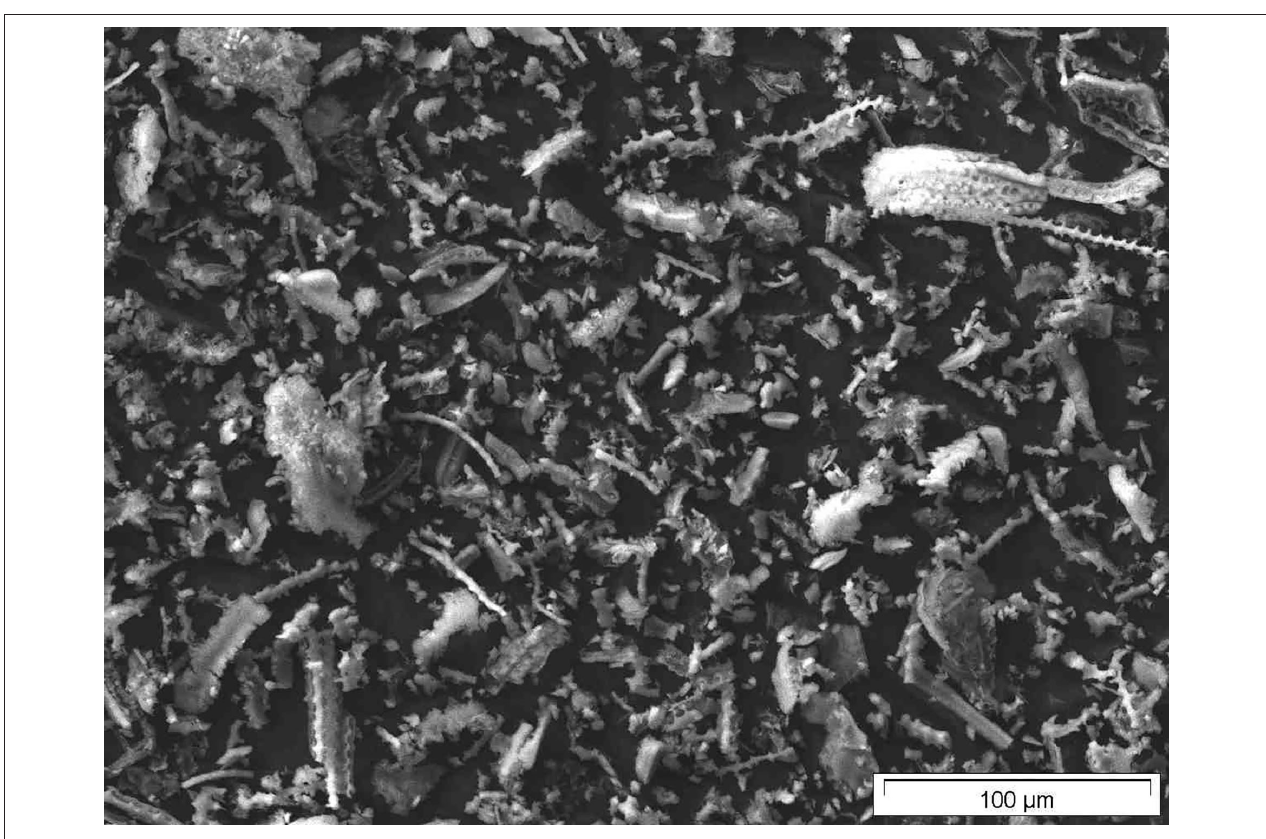
FIGURE 10 | SEM micrograph of final sample of oat